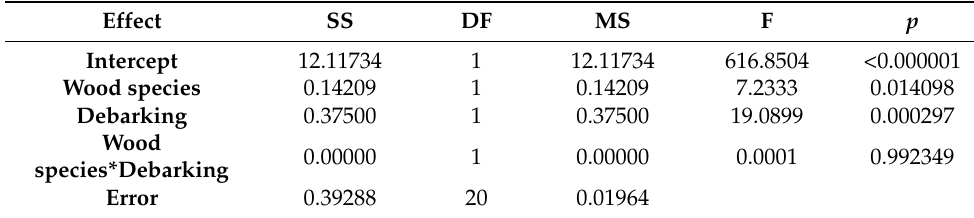
Table A4. ANOVA table for the ash content.